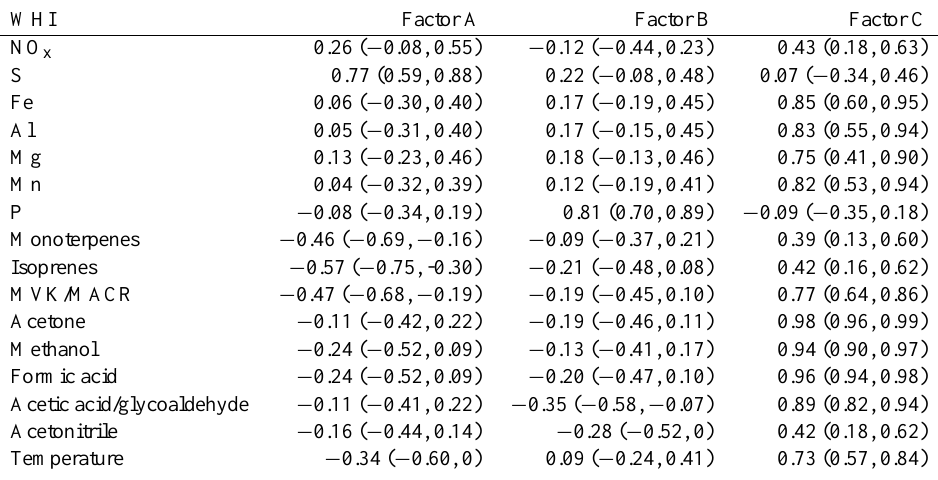
Fig. 4. PMF factor spectra for factors A–C for WHI (solid lines) and WRN (dotted lines) (a–c) . Contributions from the different organic functional groups to factors 1–4 at WHI (d–f) and WRN (g–i) . Table 1a. r coefficients between the three PMF factors and tracers at Whistler Peak. All elements, gases, and parameters in the first column have been averaged over the same time intervals as the filters were sampled over ( ∼ 24h), making up 31 points. The numbers within the brackets represent 90% confidence intervals calculated using the effective data size estimated from the first-order autocorrelation of each parameter (Mudelsee et al., 2010, algorithm